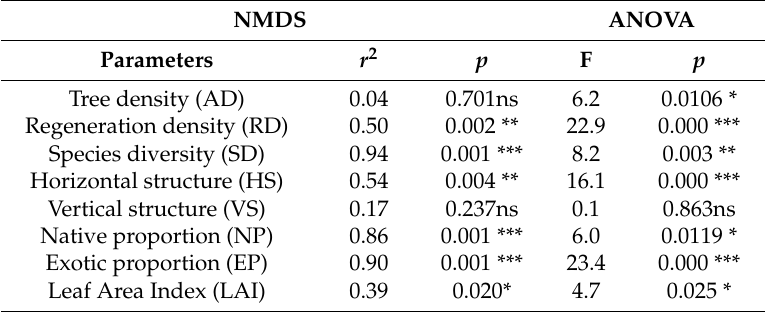
Table 2. Forest variables determining tree species composition in Eucalyptus plantations and in native forests. Ecological variables fitted on the non-metric multidimensional scaling (NMDS) ordination plot. Results of the analysis of variance among forest types, r 2 , F, and p values are given. For variable definitions, see the Material and Methods